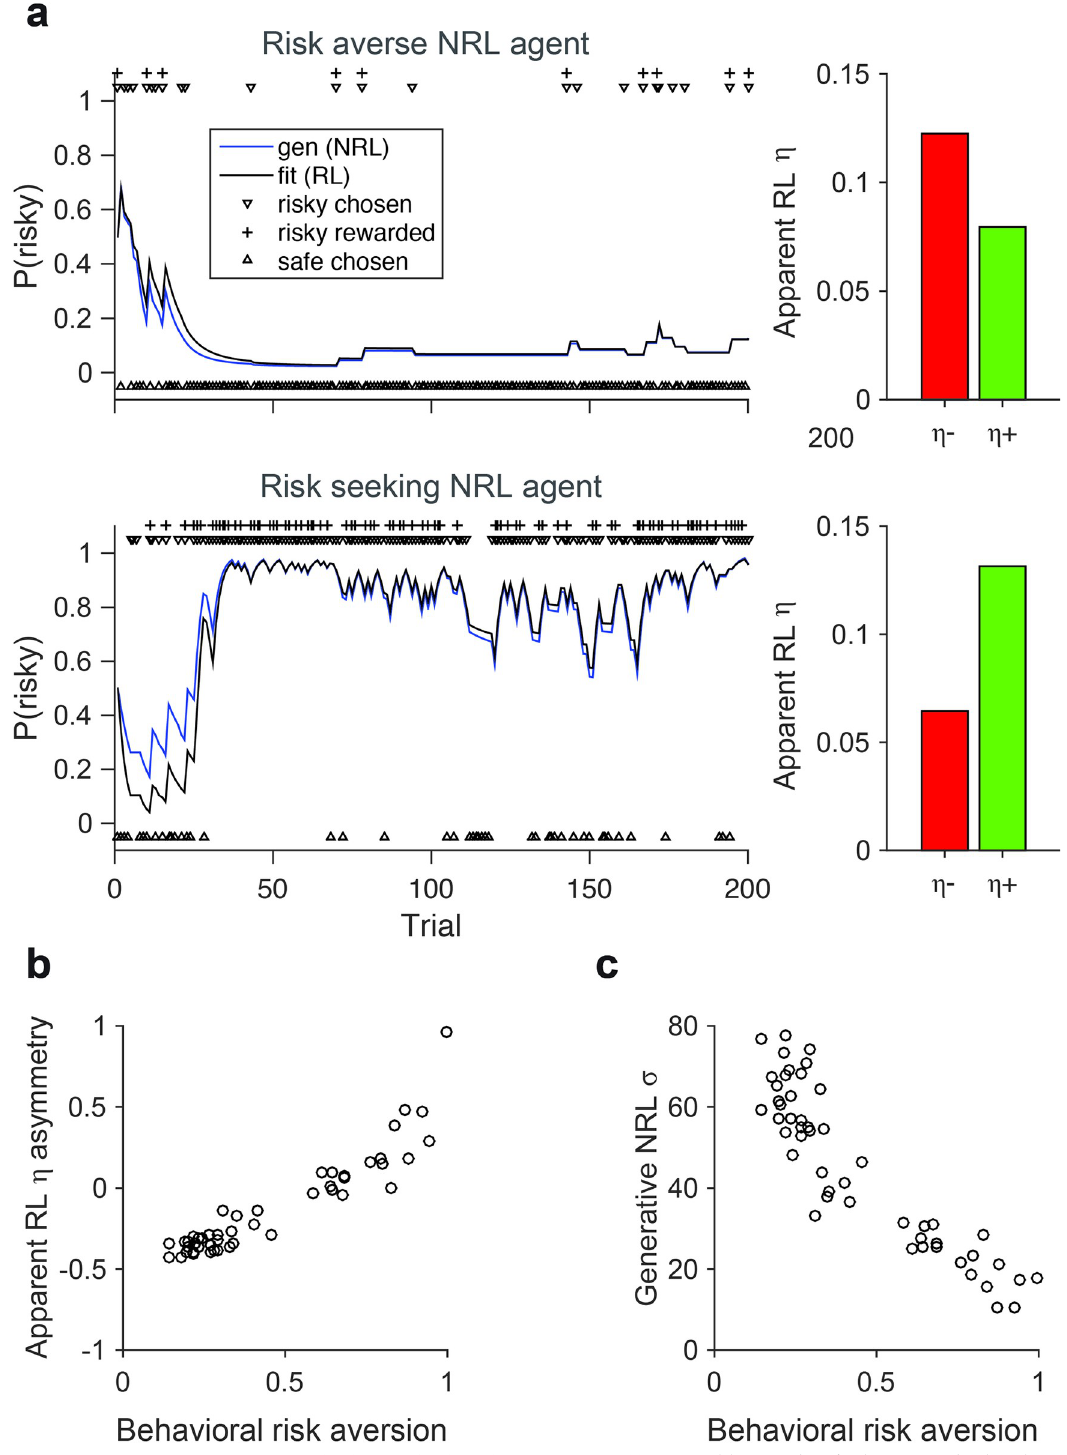
Fig 3. NRL RPE asymmetry governs the degree of risk preference in reward learning. (a) Examples of risk averse and risk seeking NRL agent behavior. Left, behavior in a task involving choices between a certain (100% chance of 20 A.U.) and a risky (50% chance of 0 or 40 A.U.) option. Blue lines, behavior of the generative NRL agent. Black lines, behavior of best fitting linear RL model with asymmetric learning rates. Right, apparent learning rates for negative and positive RPEs in linear RL model. Example risk averse σ = 20 (top); example risk seeking σ = 60 (bottom). (b) Apparent relationship between risk preference and asymmetric learning rates